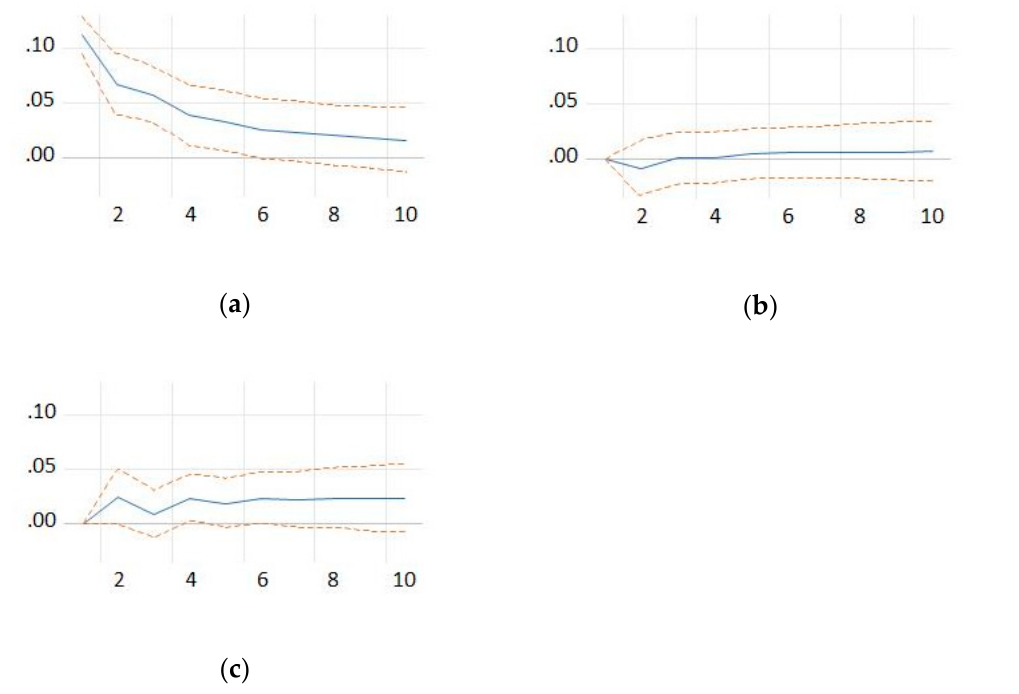
Figure 6. Response of births of enterprises to a shock from: ( a ) births of enterprises; ( b ) nominal labor productivity per person; ( c ) and persons employed in the population of deaths. Source: the authors’ own computations. Equation (13) signifies that a shock at the level of the population of dead enterprises and the number of persons employed in the population of newborn enterprises generates effects on deaths of enterprises in the previous year (Figure 7).